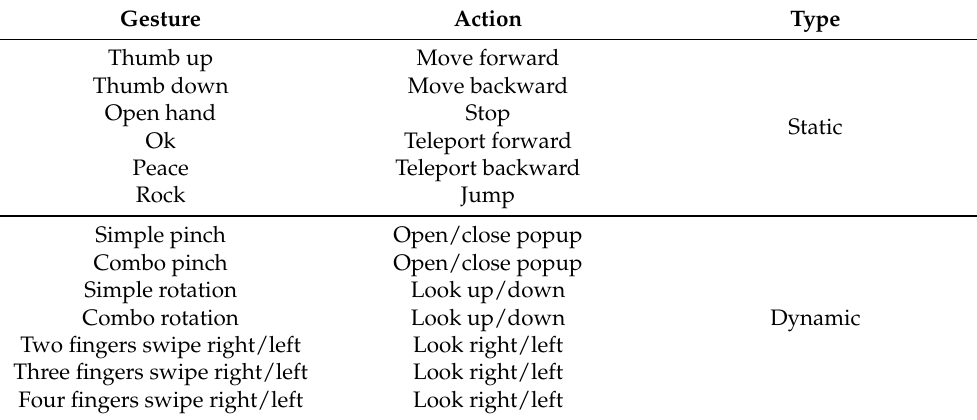
Table 1. Gestures and associated actions.